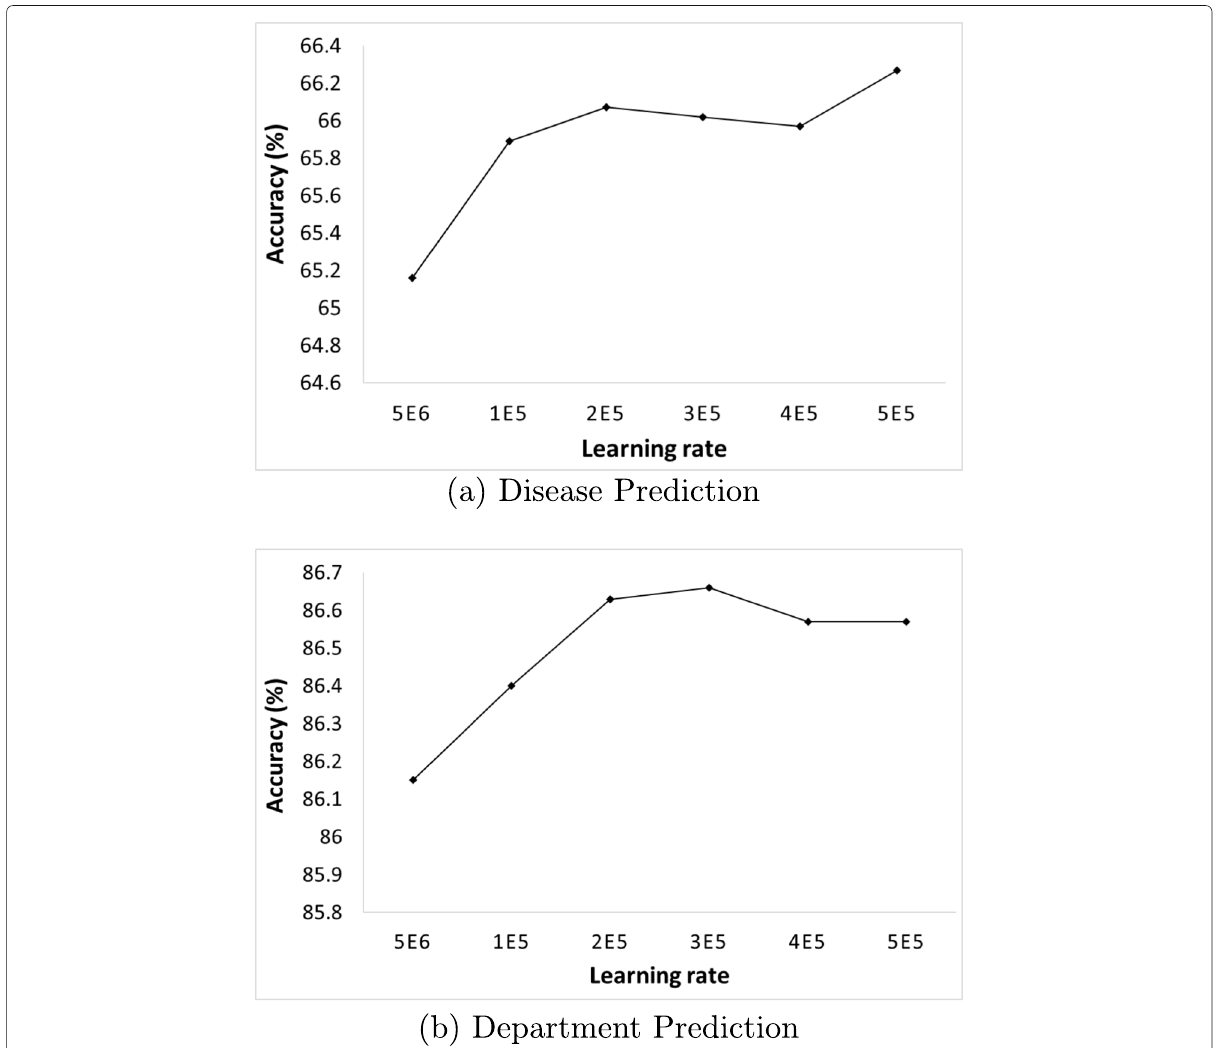
Fig. 5 The prediction accuracy with different learning rates when the number of iterations was 3